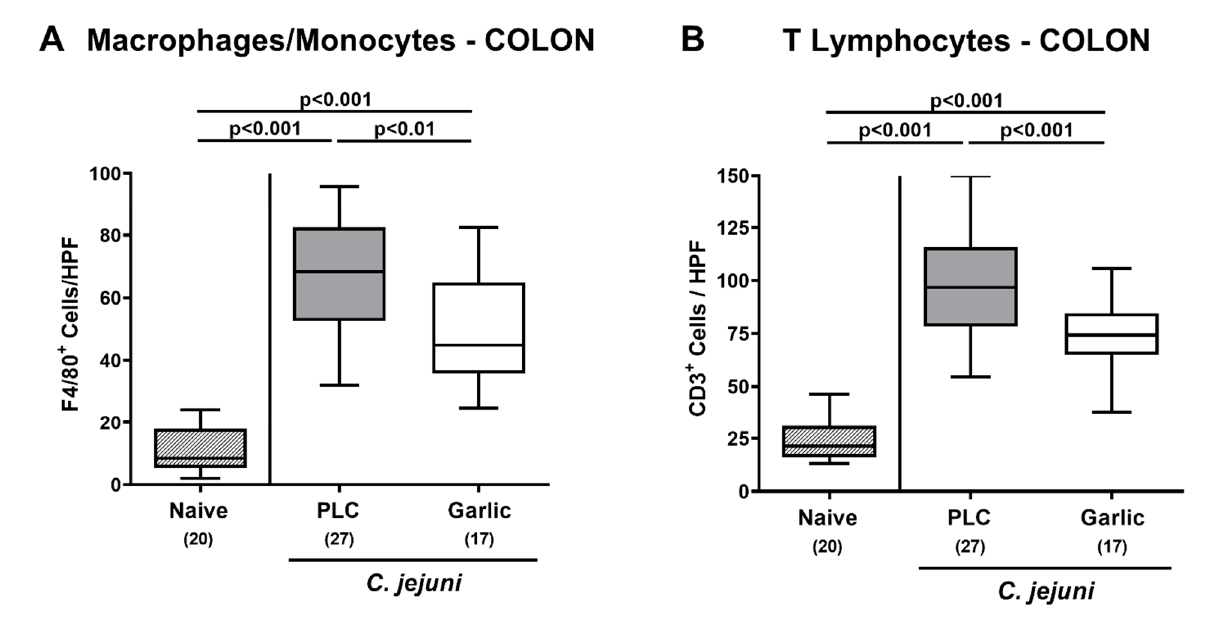
Figure 4. Colonic immune cell responses upon garlic essential oil treatment of C. jejuni infected IL-10 -/- mice. Secondary abiotic IL-10 -/- mice were orally challenged with C. jejuni strain 81-176 on days 0 and 1 followed by treatment with either garlic essential oil (white boxes) or placebo (PLC, gray boxes) via the drinking water starting on day 2 post-infection. On day 6 post-infection, the mean numbers of ( A ) macrophages and monocytes (positive for F4/80) and of ( B ) T lymphocytes (positive for CD3) out of six high power fields (HPF, 400× magnification) were enumerated microscopically in paraffin sections following immunohistochemical staining. Naive mice (hatched boxes) served as non-infected and untreated cohort. Box plots (indicating the 25th and the 75th percentiles), whiskers (indicating maximum and minimum values), medians (black bar inside box), significance levels ( p values) determined by the one-way ANOVA with Tukey post-correction and the Kruskal-Wallis test and Dunn’s post-correction, and the total number of mice (in parentheses) are shown (pooled data from four independent experiments).